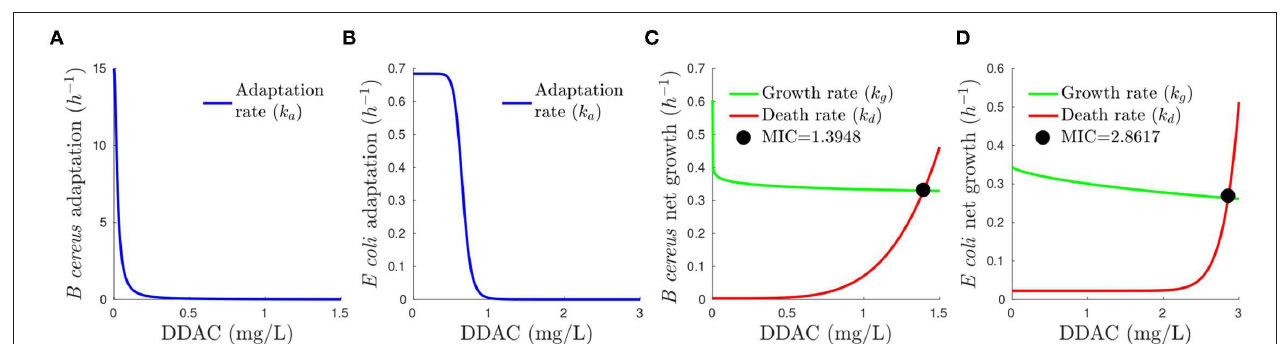
FIGURE 3 | Dependence of adaptation, growth (under the assumptions of non-inhibition by substrate availability and cell density), and death specific rates on DDAC. The bacteriostatic action is seen in the decrease of growth rate (kg) and the bactericidal in the increase of death rate (kd) as a function of DDAC concentration for B. cereus (A) and E. coli (B) . The intersection of growth and death rates gives the minimum concentration of DDAC for which net growth is zero (Coates et al., 2018) for B. cereus (C) and E. coli (D) .